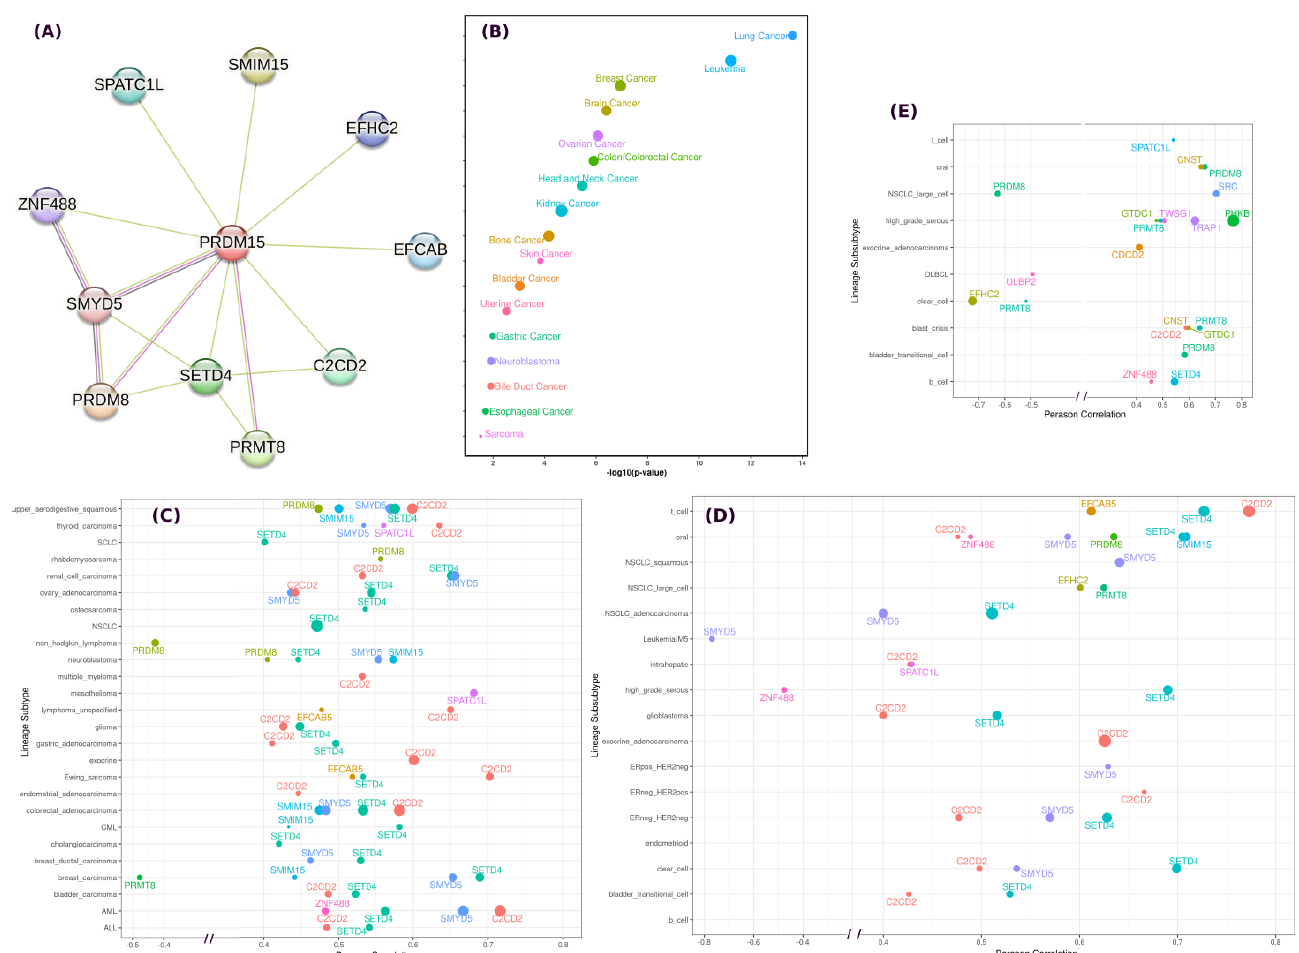
Figure 3. ( A ) The predicted protein-PRDM15 associations, both functional and physical, are indicated by edge. This figure was generated using the STRING web server. ( B ) SETD4 co-expression profile with PRDM15. The x-label indicates the p -value significance. The size of the balls indicates the Pearson correlation of the PRDM15 expression and SETD4 expression across different cancer cell lines. The expression data are based on Expression 22Q2 Public. ( C ) The expression of these genes that are associated with PRDM15 were further analyzed based on Lineage subtype and subsubtype ( D ). ( E ) The correlation between PRDM15 expression and the methylation profile of associated genes. Note that the x-axis only shows a Pearson Correlation of less than -0.4 and larger than 0.4, while y-axis indicates the lineage subsubtype. The size of the dots indicates the statistical significance based on the -log10( p -value) with a cutoff of p < 0.05 and the number of samples is more than 10.